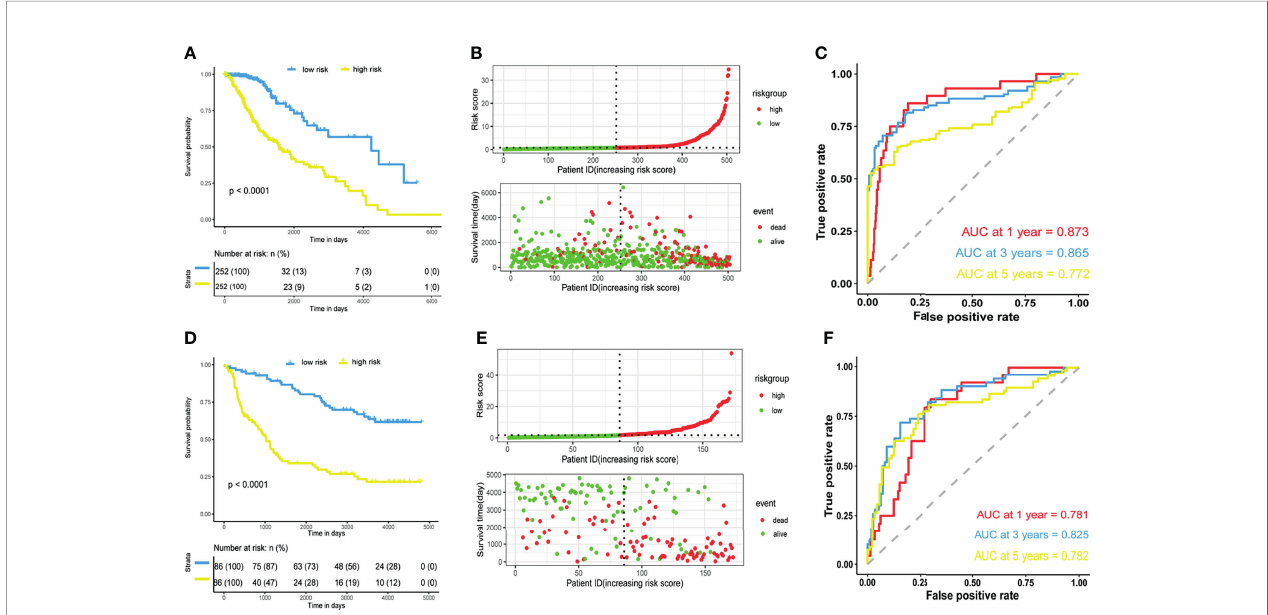
FIGURE 2 | Prognostic performance of the m5C-related lncRNAs signature. (A, D) Kaplan-Meier curve showing a better overall survival in low-risk group than the high-risk group in the TCGA and CGGA datasets. (B, E) Risk score distribution of patients based on m5C-related lncRNAs signature and survival status in the TCGA and CGGA datasets. (C, F) Receiver operating characteristic (ROC) curves showing performance of the signature in predicting 1/3/5-year overall survival in the TCGA and CGGA datasets.